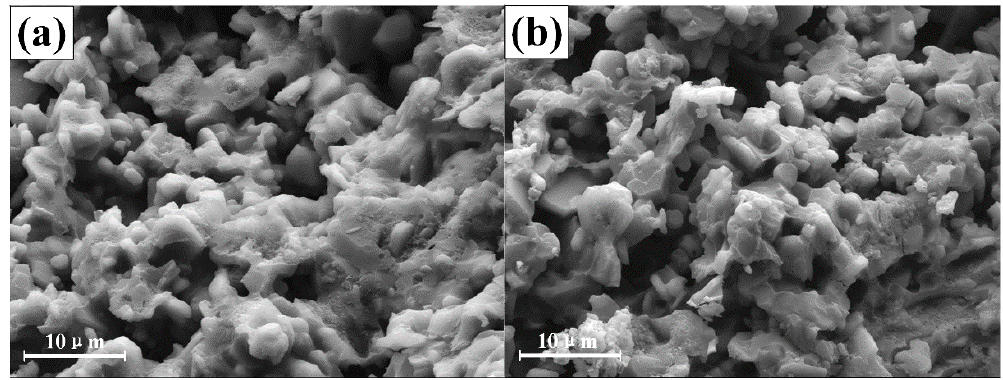
Figure 12. The microstructure of adhesive curing with the CT-1 ( a ) and CT-6 ( b ) temperature curve.